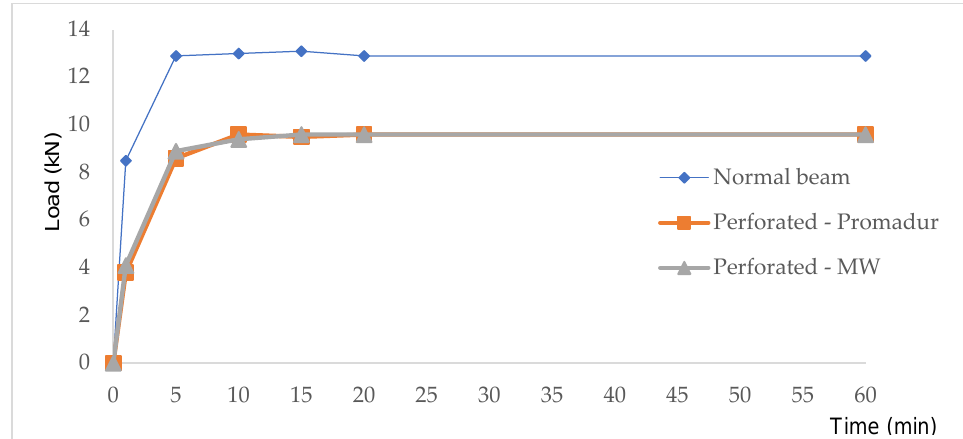
Table 5. Observations during fire testing—normal beam.